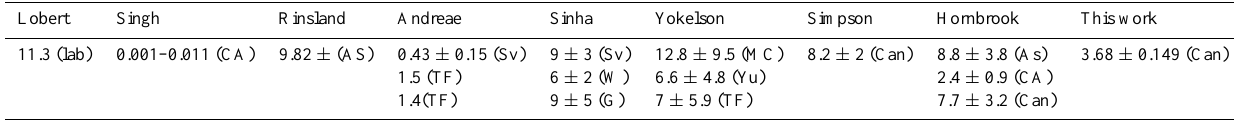
Table 2. HCN:CO NEMRs as quoted in literature and the calculated NEMR for HCN from data collected throughout the BORTAS campaign, excluding flight B622. NEMR ratio units are pptppb − 1 .